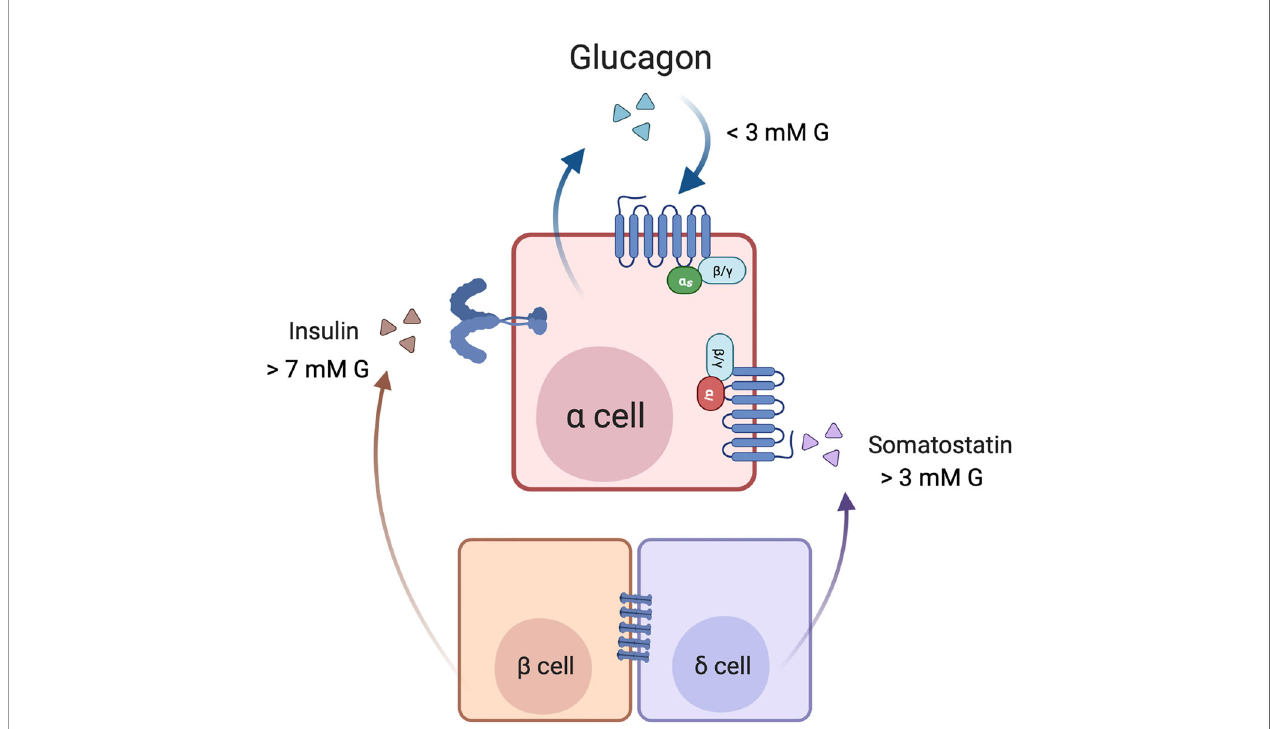
FIGURE 3 | Cross-talk among a , b , and d -cells in the paracrine regulation of glucagon secretion. Under low glucose (1-3 mM) conditions, secreted glucagon may act in an autocrine feed-forward loop. In high glucose (> 7 mM) conditions, glucose metabolism in b cells leads to insulin release, and insulin inhibits glucagon secretion by signalling through its receptor on the alpha cell. Additionally, electrical coupling of the beta and delta cells through gap junctions contributes to somatostatin release. Somatostatin may also be secreted independently of insulin when glucose concentrations are > 3 mM. Somatostatin binds to SST receptor 2 (SSTR2) on the a cell membrane, where signalling through G i inhibits glucagon secretion. Created with